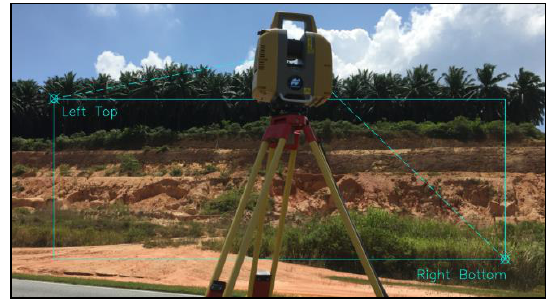
Figure 25. Determine scanning area